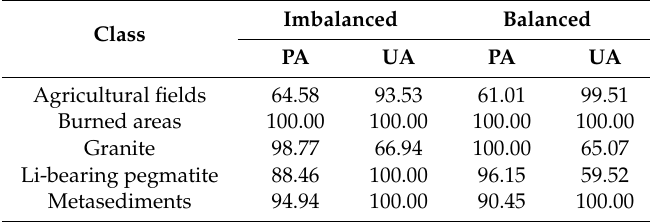
Figure 6. Confusion matrix for the RBF-SVM model built on the balanced dataset. Table 5. User’s and producer’s accuracy (UA and PA) for Both the Linear-SVM and Radial Basis Function (RBF)-SVM Models. Values in percentage